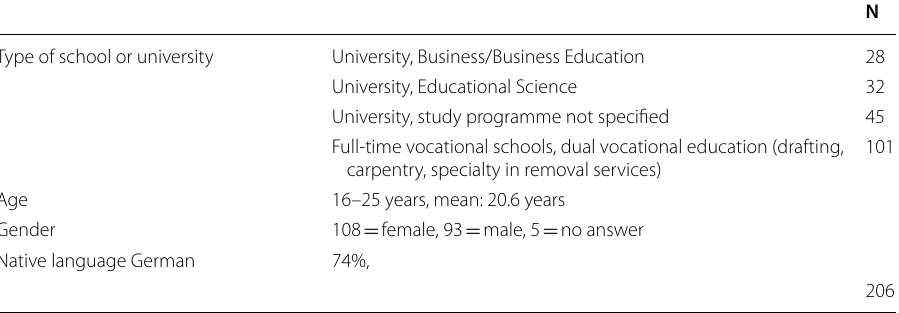
Table 1 Overview of the